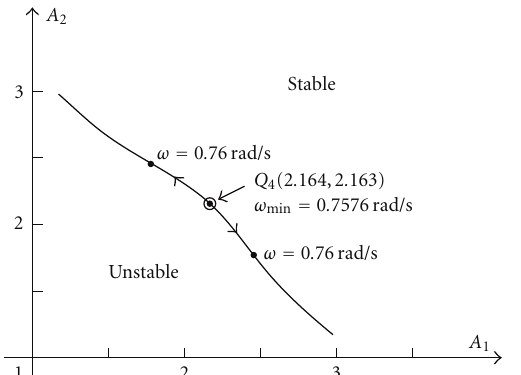
Figure 7: Root loci of limit cycles with two doubled-valued nonlin-